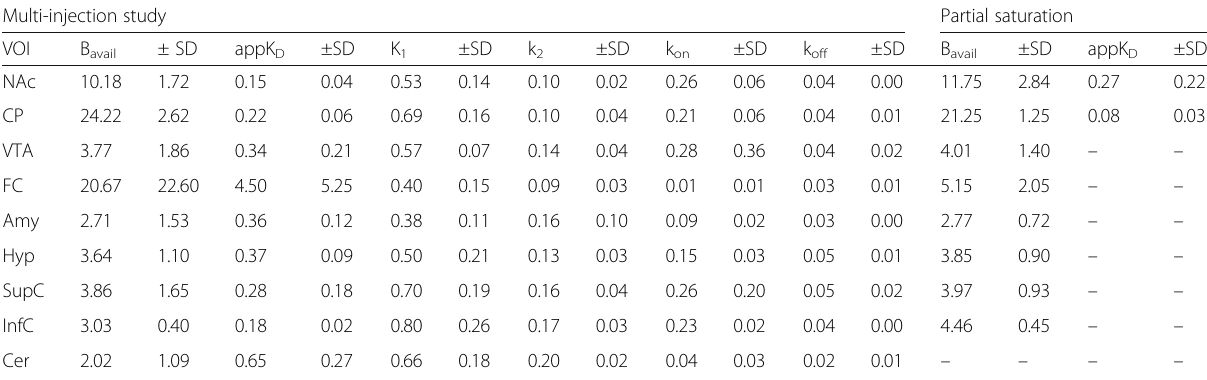
Table 2 Mean and standard deviations of binding parameter estimates obtained from 3 rats of the multi-injection study and from 4 rats of the partial saturation